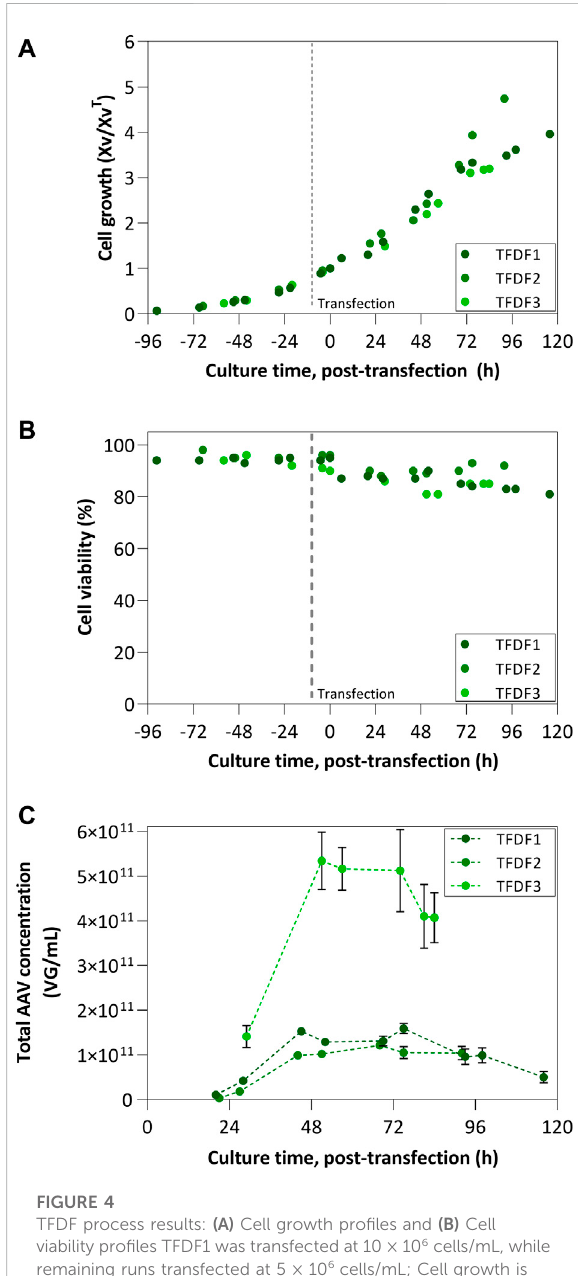
FIGURE 3 ATF process results: (A) Cell growth pro fi les and (B) Viability pro fi les; ATF1 was transfected at 10 × 10 6 cells/mL, while remainingrunsweretransfectedat5×10 6 cells/mL;Cellgrowth is represented by normalizing viable cell concentration by the VCC at the time of transfection. (C) Concentration of total AAV produced considering intracellular, extracellular and permeate fractions.